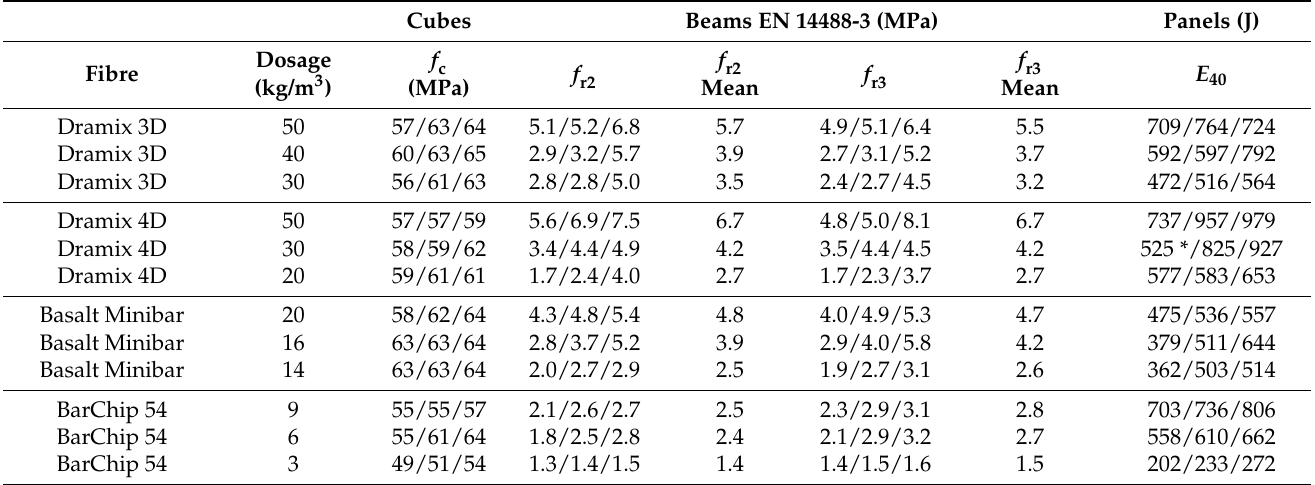
Table 7. Compressive strength, residual strength and energy absorption for shotcrete with steel, synthetic and basalt fibres with various